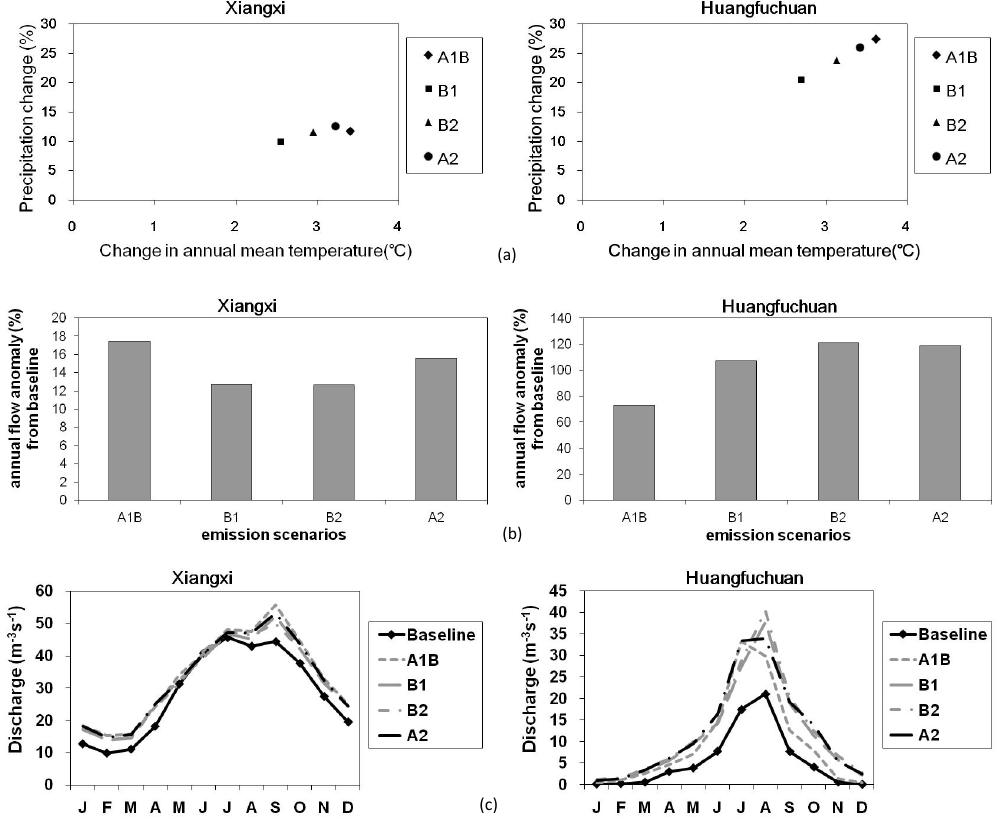
Fig. 4. (a) Projected changes in annual mean temperature ( ℃ ) and annual precipitation (%), (b) annual and (c) monthly discharge for HadCM3 different emission scenarios.